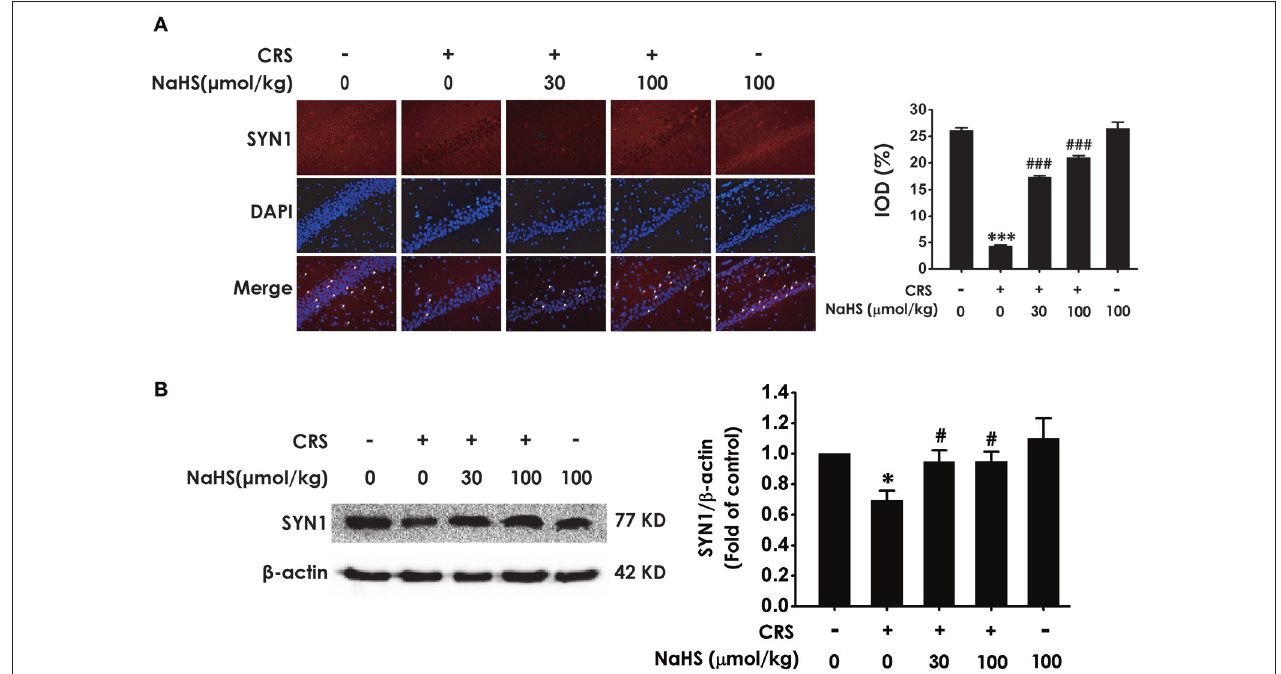
FIGURE 3 | Effects of H 2 S on the suppressed synapse formation in the hippocampus of CRS-treated rats . SD rats were cotreated with CRS and NaHS (30, 100 µ mol/kg, i.p.) for 4w. The levels of hippocampal SYN1 were analyzed by immunofluorescence technique [ (A) , magnification × 400] and western blot (B) . β -actin was used as an internal control. Values are expressed as means ± SEM ( n = 3). * P < 0.05, *** P < 0.001, vs. control group; # P < 0.05, ### P < 0.001, vs. CRS-treated alone group.